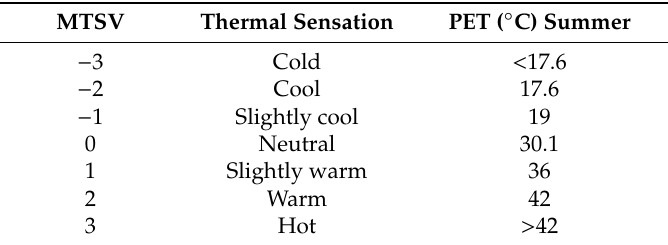
Table 2. PET at di ff erent levels of thermal sensation (only votes of − 1, 0, and + 1 represent satisfaction with the thermal environments [62].